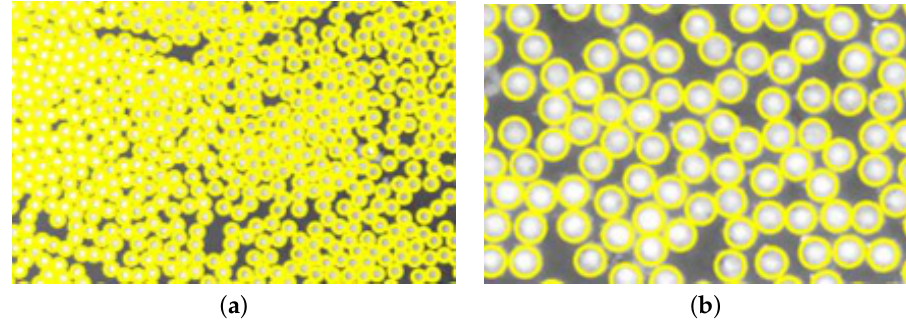
Figure 10. Blob analysis for ( a ) 20 × magnification, and ( b ) 50 × magnification